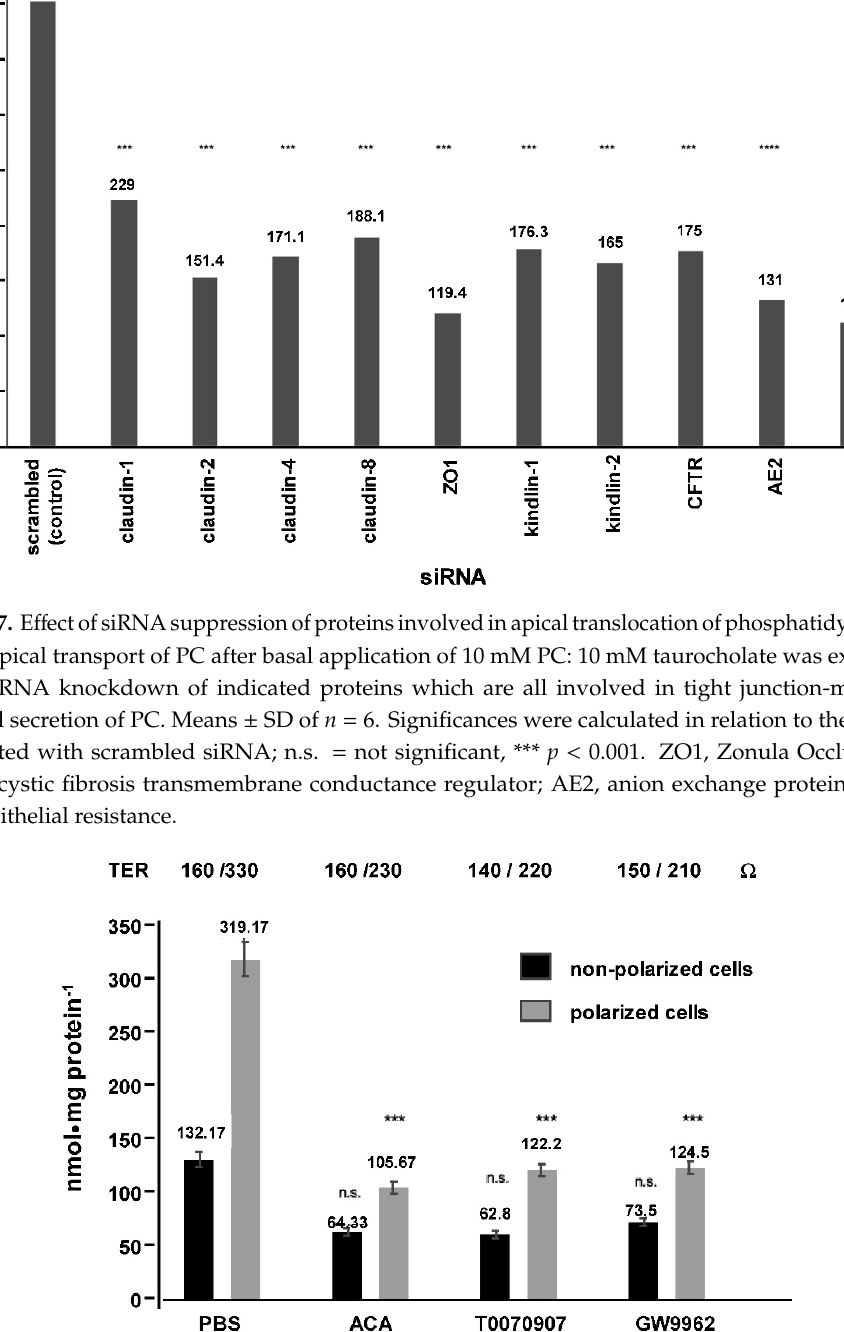
Figure 8. E ff ect of disruption of tight junctions (TJ) by acetaldehyde (ACA) or the indicated peroxisome proliferator-activated receptor γ (PPAR γ ) inhibitors on apical transport of phosphatidylcholine (PC). TJ were disrupted by exposure to ACA vapor or incubation of upper transwell chambers with the PPAR γ inhibitors. Then apical transport of 10 mM PC : 10 mM taurocholate for 1 h was registered. Means ± SD of n = 6. Significances were calculated separately for non-polarized and polarized Mz-ChA-1 cells and compared to phosphate-buffered saline (PBS)-treated controls; n.s. = not significant, *** p < 0.001.